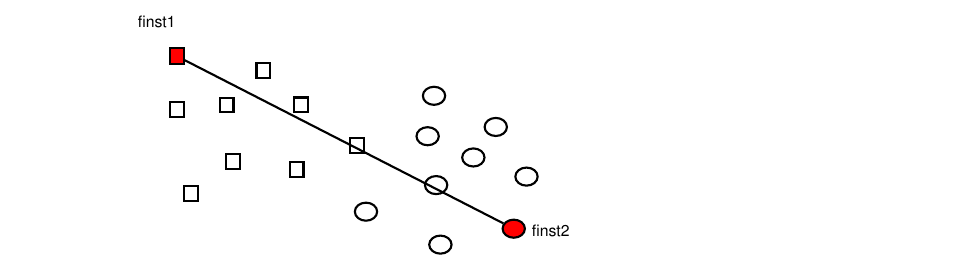
Figure 1. The RSP3 algorithm divides the subset according to its furthest instances finst 1 and finst